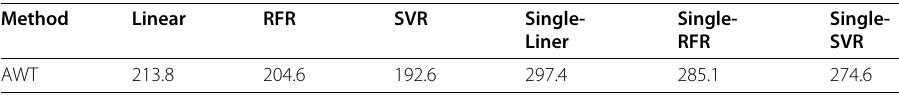
Table 6 Backfilling performance Method